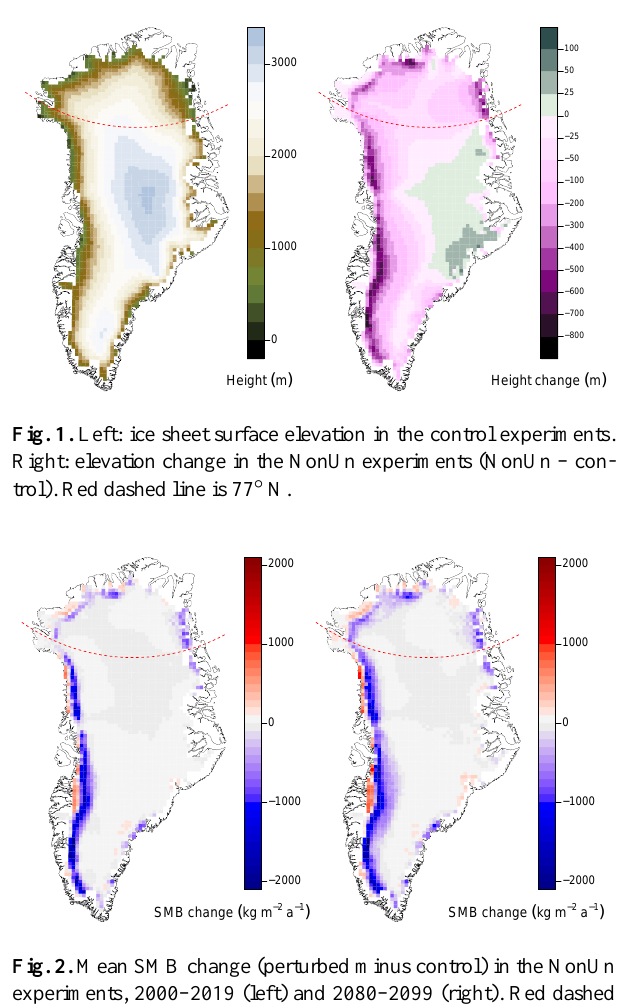
Fig. 2. Mean SMB change (perturbed minus control) in the NonUn experiments, 2000–2019 (left) and 2080–2099 (right). Red dashed line is 77 ◦ N. 31